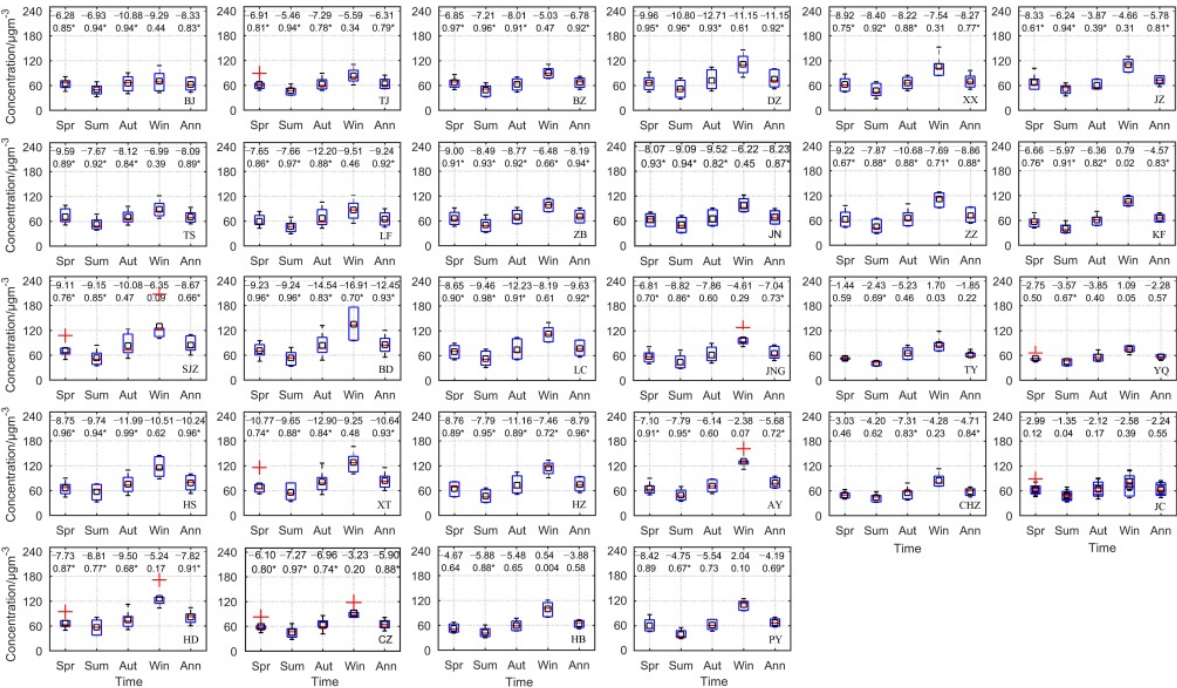
Figure 2. The temporal variation of mean PM 2.5 concentration in the 28 air transport channel cities during 2014–2019. In each box plot, the bottom and top of the box mean the 25th and 75th percentiles, respectively; horizontal red lines indicate median values; open black squares represent mean values; whiskers indicate 1.5 times the interquartile range; and red crosses represent outliers. Linear regression slopes and R 2 values are provided for each city (* p < 0.05): BJ, Beijing; TJ, Tianjin; SJZ, Shijiazhuang; TS, Tangshan; LF, Langfang; BD, Baoding; CZ, Cangzhou; HS, Hengshui; XT, Xingtai; HD, Handan; BZ, Binzhou; DZ, Dezhou; ZB, Zibo; JN, Jinan; LC, Liaocheng; JNG, Jining; HZ, Heze; AY, Anyang; HB, Hebi; PY, Puyang; XX, Xinxiang; JZ, Jiaozou; ZZ, Zhengzhou; KF, Kaifeng; TY, Taiyuan; YQ, Yangquan; CHZ, Changzhi; JC, Jincheng.